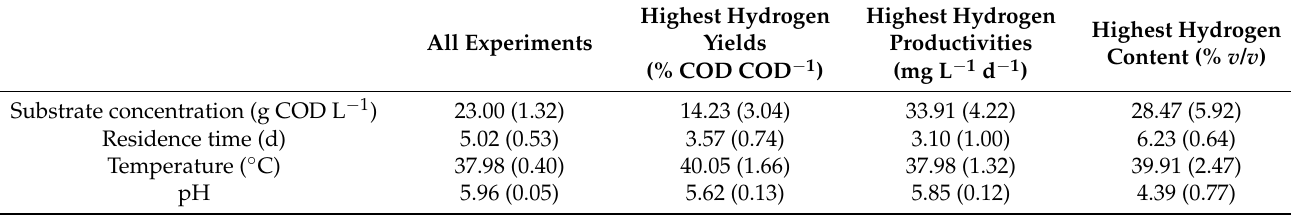
Table 4. Mean values of operating parameters, with standard error (in bracket), for process perfor- mance parameters above 90th percentile compared with those of all